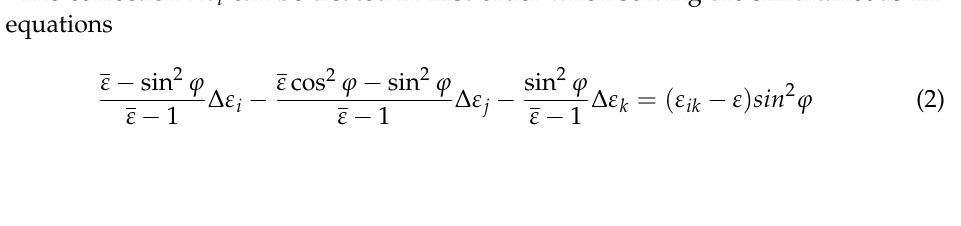
( a ) zigzag and ( b ) armchair directions.